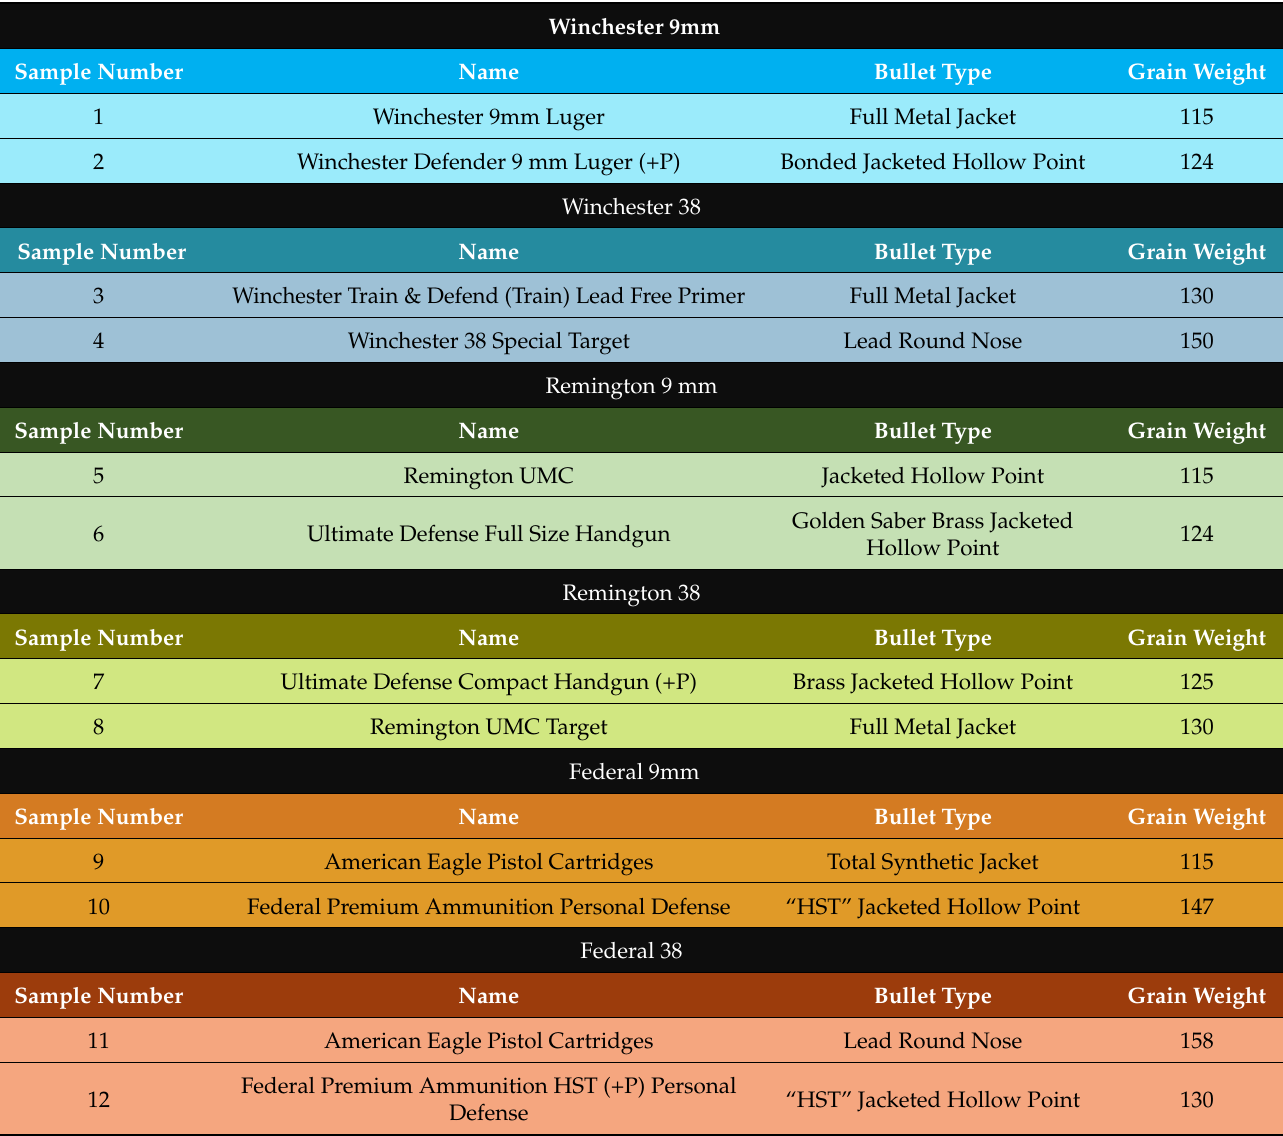
Table 1. Smokeless powder samples obtained from ammunition with two unique caliber types and produced by three manufacturers. Ammunition-specific parameters such as detailed names, bullet types, and grain weights are included. Grain weight is a unit defined as 0.065